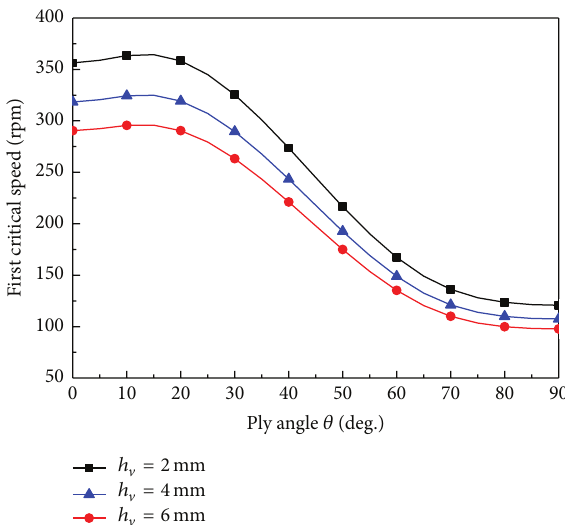
Figure 11: The critical speed versus fiber angle for various thick- nesses of viscoelastic damping layer ( ℎ 𝑐 = 2